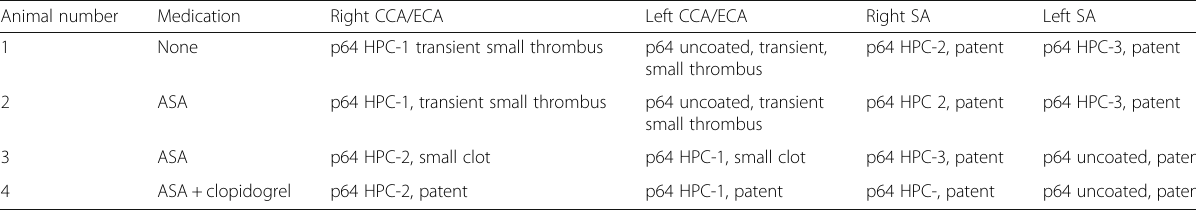
Table 3 Summary of the end-procedural angiography results Animal